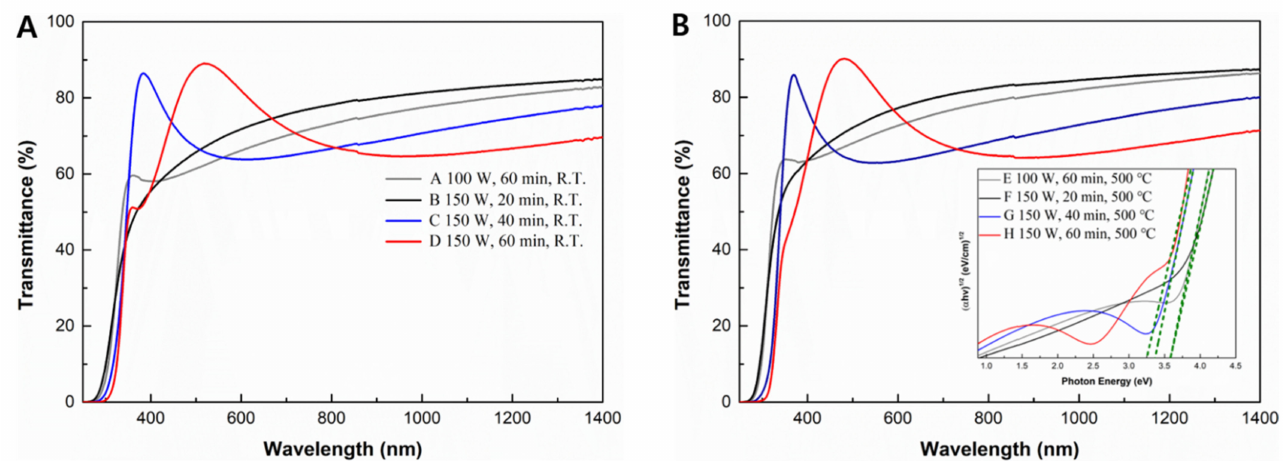
Figure 10. UV/Vis spectra of ( A ) TiO x thin films (non-annealed) and ( B ) TiO 2 thin films (annealed at 500 ◦ C), and Tauc plot of TiO 2